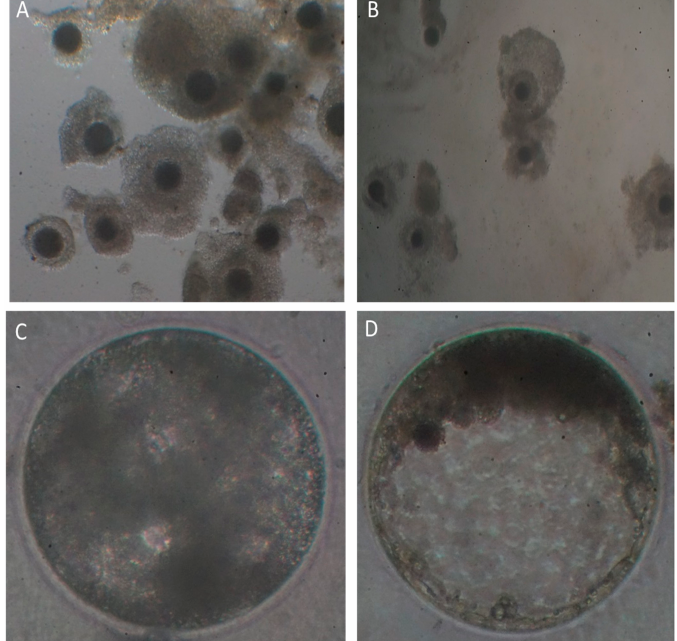
Figure 1. Representative images of COCs collected by OPU ( A ) from live alpacas or by manual follicular aspiration from slaughterhouse ovaries ( B ), early ( C ) and expanded blastocyst ( D ) produced in vitro. Table 2. Total number of COCs recovered and in vitro matured, cleavage, morula and blastocyst rate and total number of blastocysts produced by female using oocytes collected from slaughter- house ovaries or in vivo donors using transvaginal follicular aspiration in alpacas. Groups